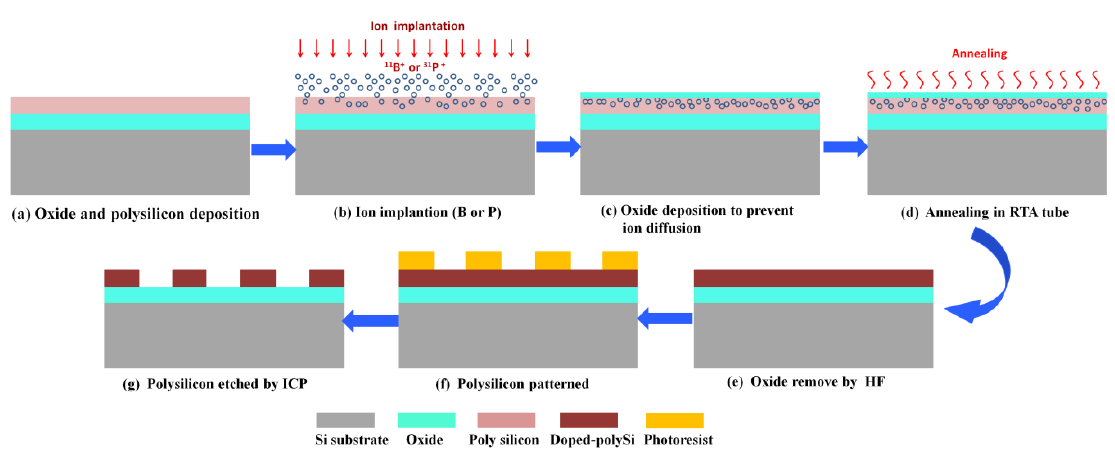
Figure 1. Schematic diagram of the process for fabricating heavily doped polysilicon strip structures. Table 1. Injection and annealing conditions of polysilicon.